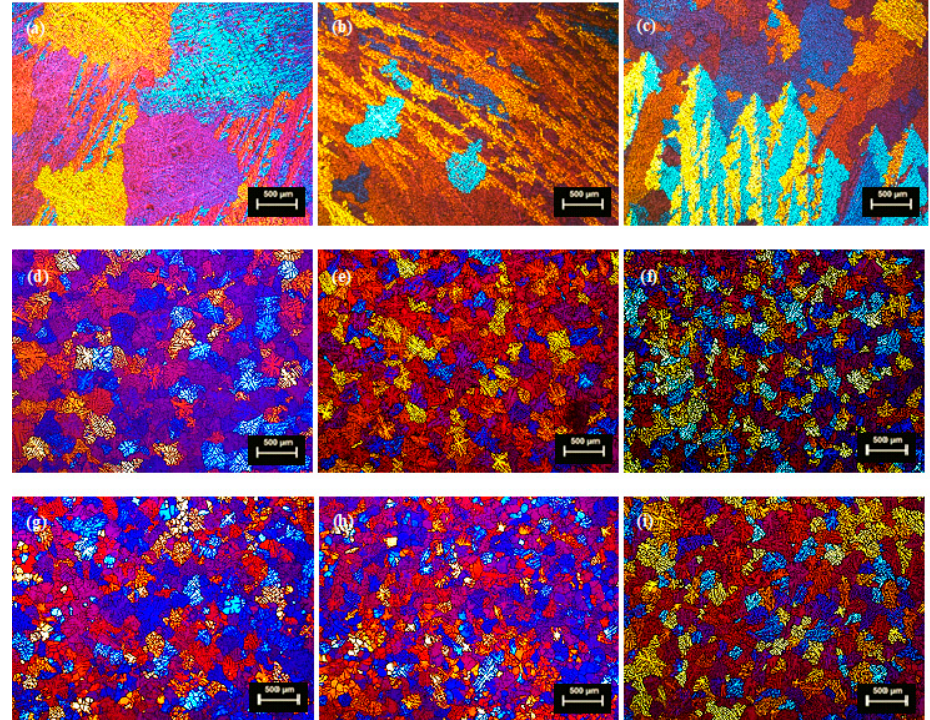
Figure 4. Microstructure of direct chill cast billets of Taint Tabor TT-6111 (3); ( a , d , g ) at the center, ( b , e , h ) half radius and ( c , f , i ) edge of billet. Where ( a , b , c ) DC billet, ( d , e , f ) DC-GR billet and ( g , h , i ) MC-DC